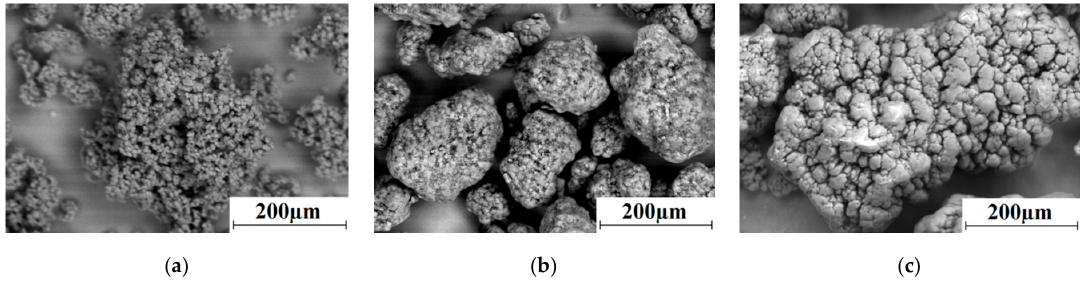
Table 1. The powders used for the fabrication of the samples.